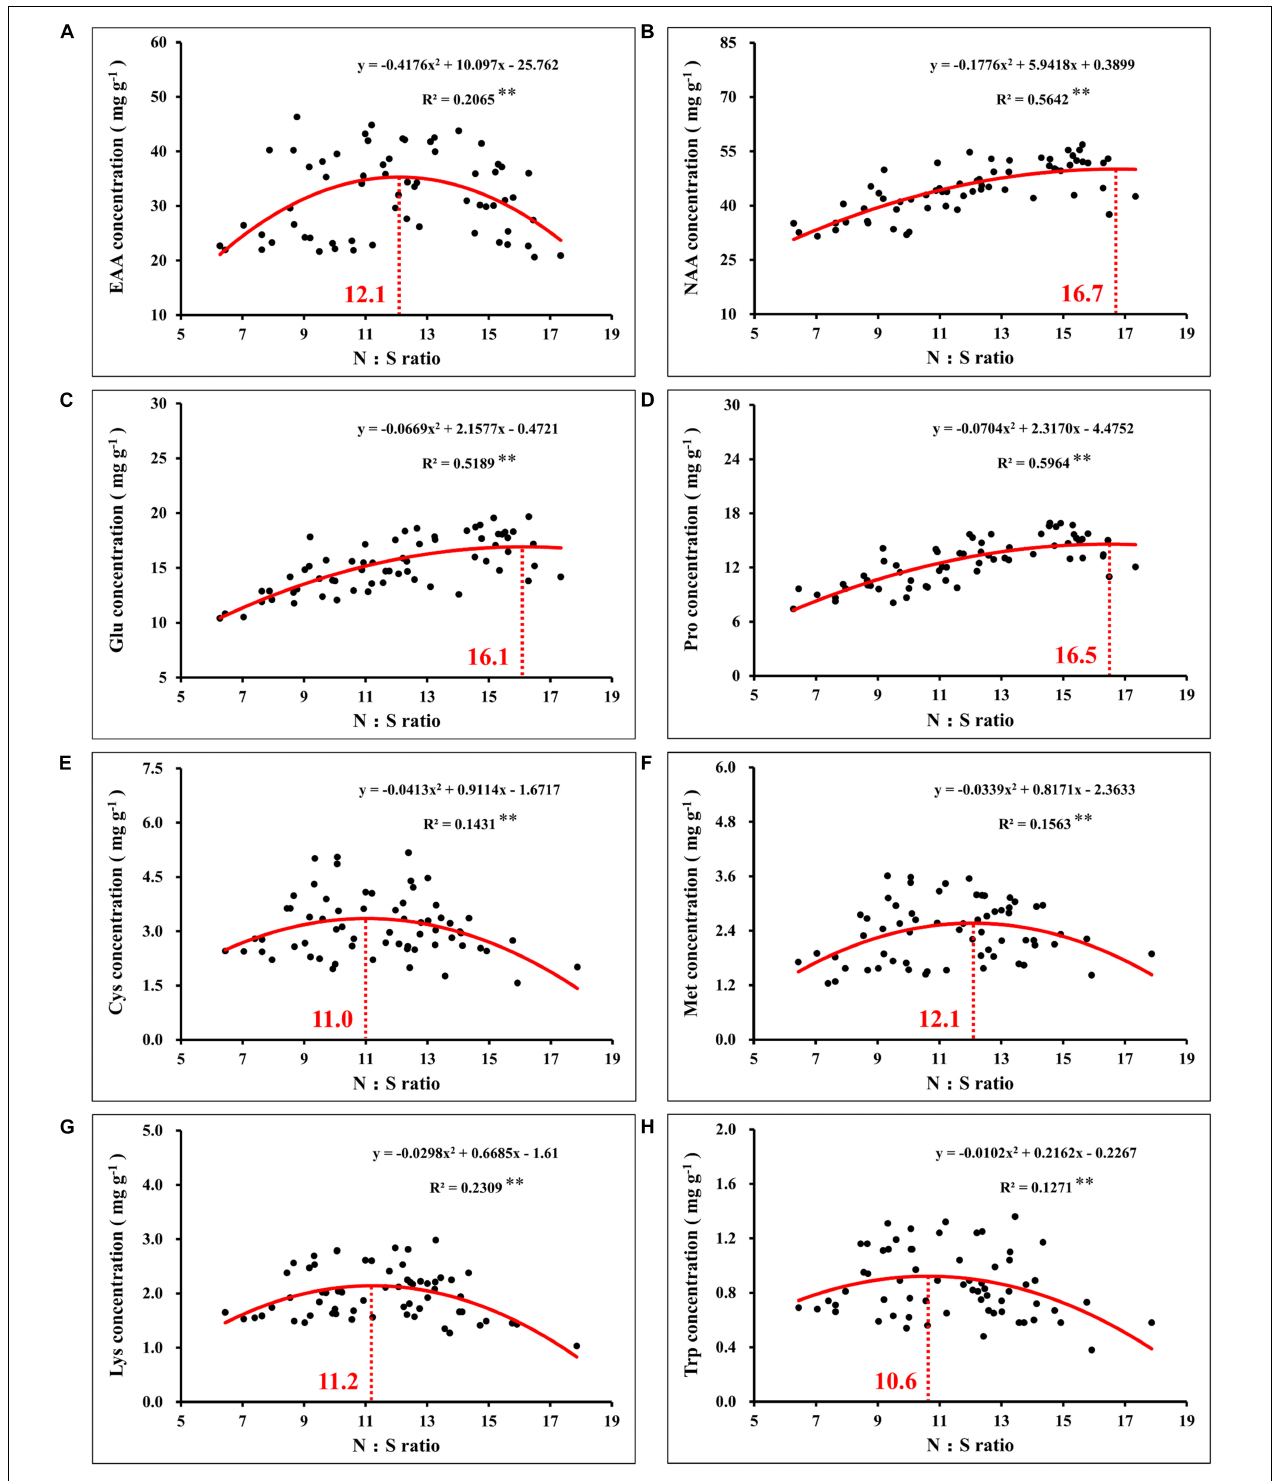
FIGURE 10 | Correlation analysis between the concentration of total essential amino acids (A) , total non-essential amino acids (B) , glutamate (C) , proline (D) , cysteine (E) , methionine (F) , lysine (G) , tryptophan (H) , and N:S ratio in maize grains. In this image, the red curve shows the correlation between the concentration of amino acids and N:S ratio in maize grains ( n = 64), and the intersection of the red dotted line and the red curve indicates the maximum value of the curve. EAA, total essential amino acids; NAA, total non-essential amino acids; Glu, glutamate; Pro, proline; Cys, cysteine; Met, methionine; Lys, lysine; Trp, tryptophan.